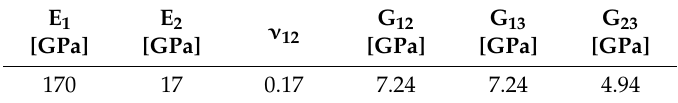
Table 2. Mechanical properties of CFRP (Carbon Fiber Reinforced Polymer)